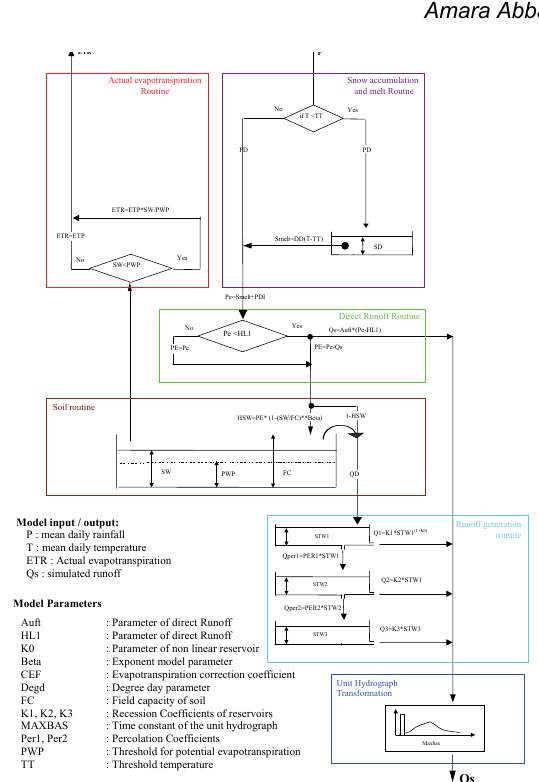
Fig. 1 HBV model